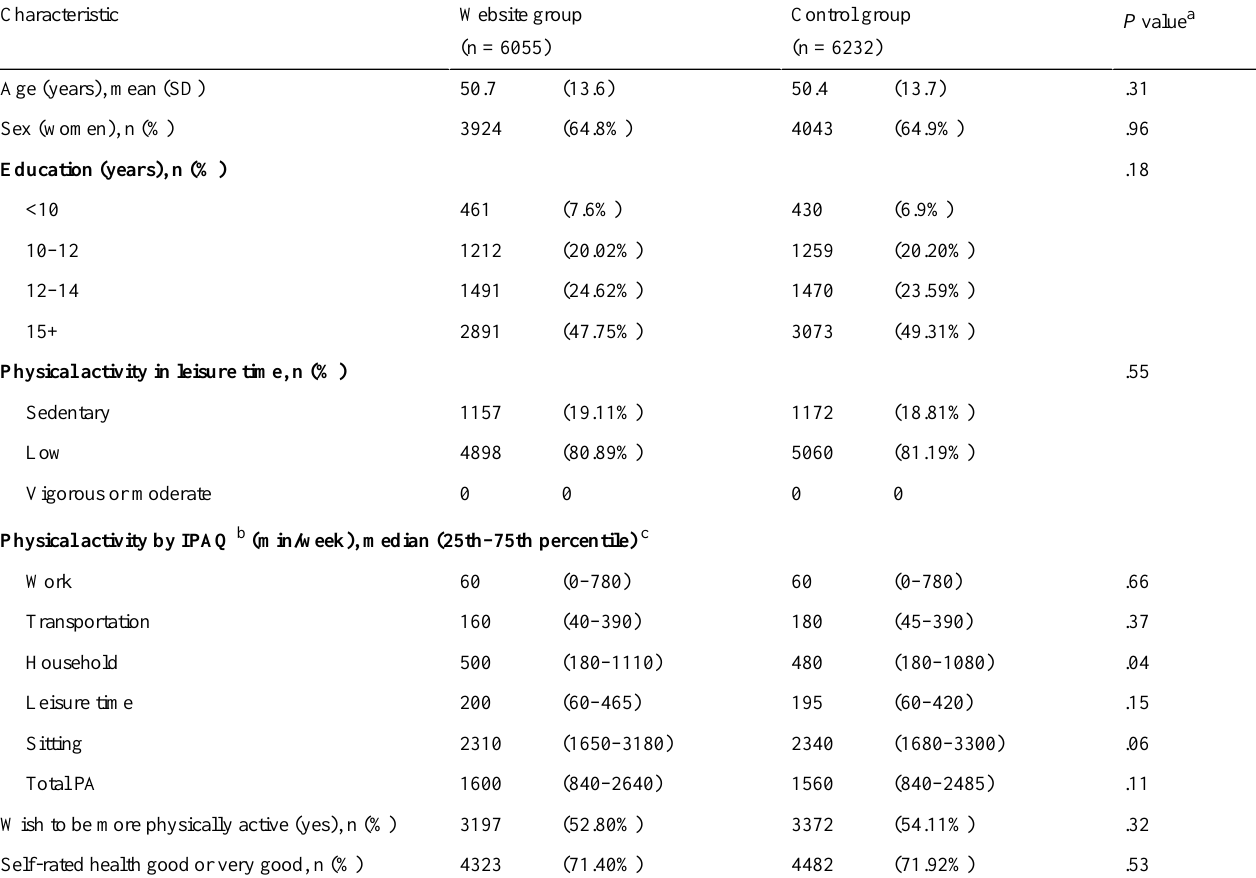
Table 2. Baseline characteristics of the participants by website and control group (Denmark, 2008).